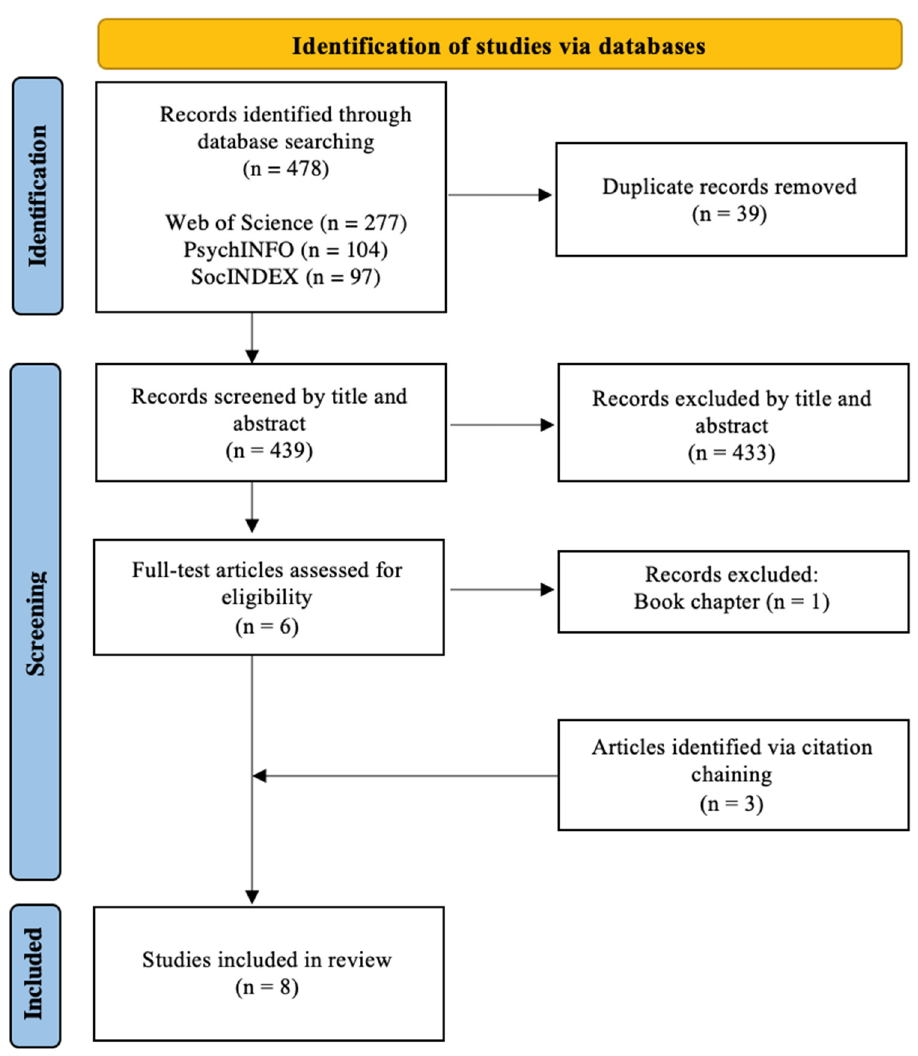
Figure 2. Article search, article screening and article selection.